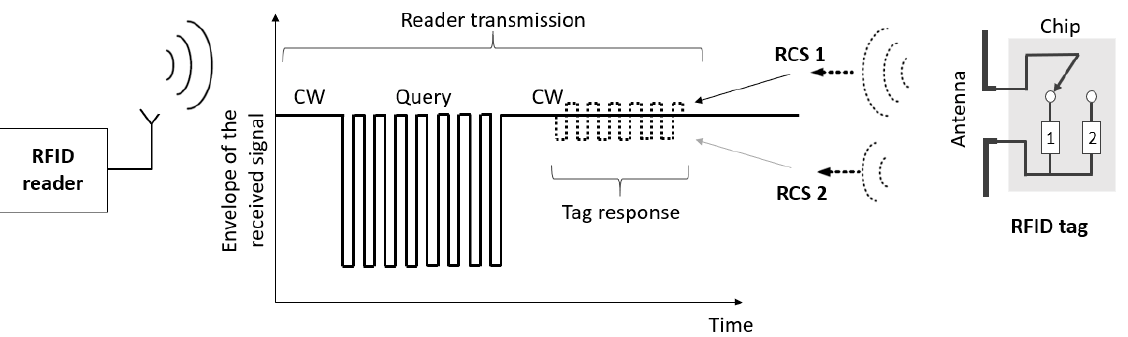
Figure 3. Principle of a passive RFID system.